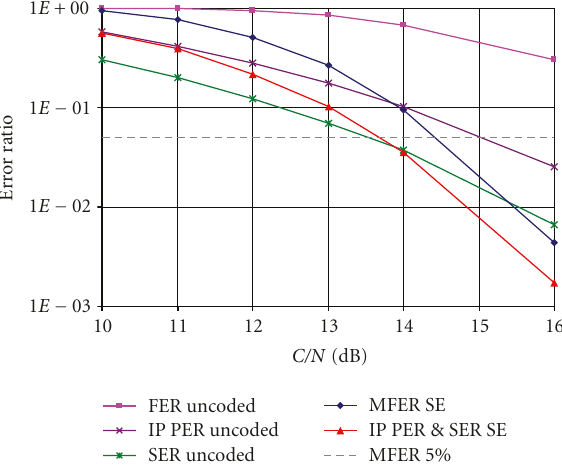
Figure 4: MPE-FEC frame error rates (MFER), IP packet error rates (IP PER) and byte error rates (SER) after coded, and uncoded data link layer for the Vehicular Urban